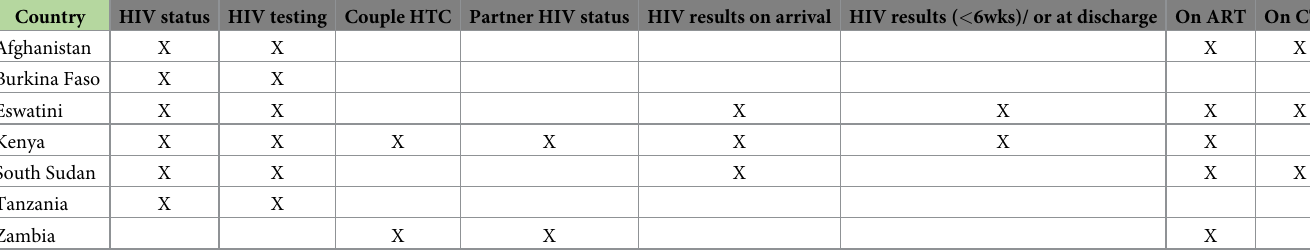
Table 8. HIV Testing and treatment